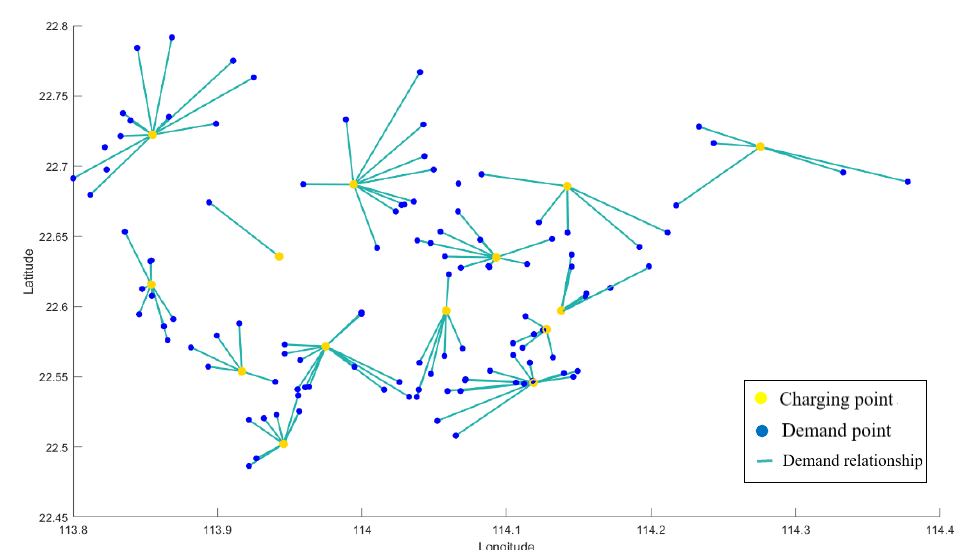
Figure 25. Optimization results of charging station site selection.